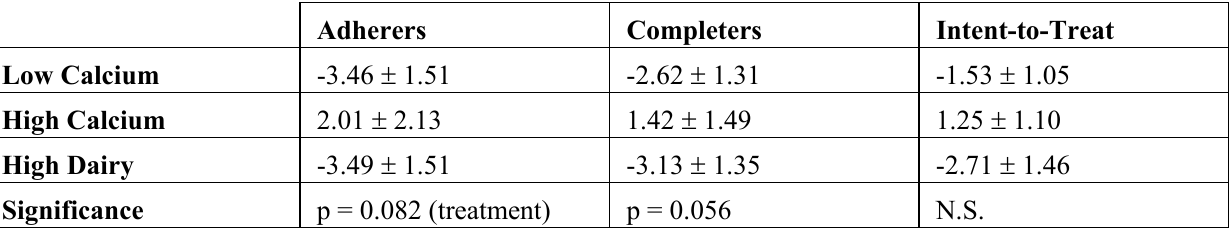
Table 5. Changes in Diastolic Blood Pressure (mmHg) in Response to Dietary Treatments 1 Analysis.